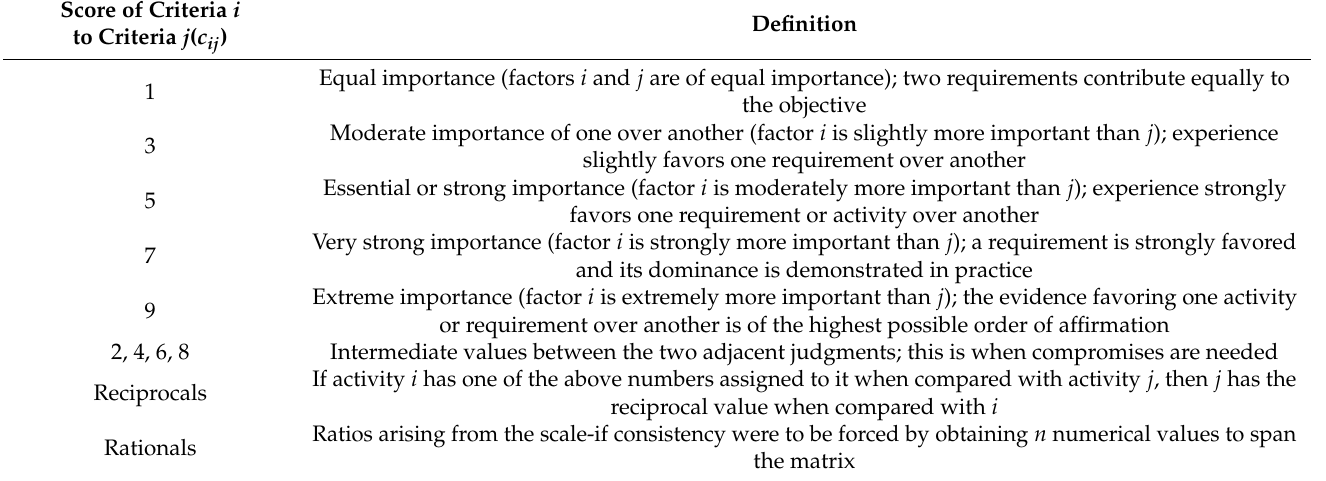
Table 2. Saaty’s scale for pairwise comparison